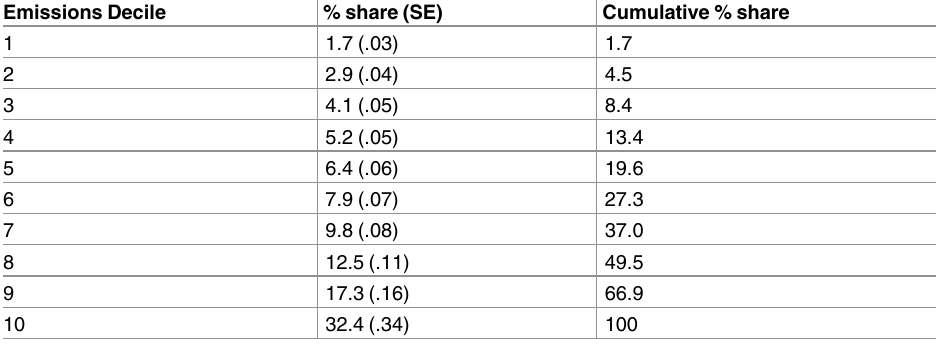
Table 3. Decile shares of UK motorist households’ CO 2 emissions from motor